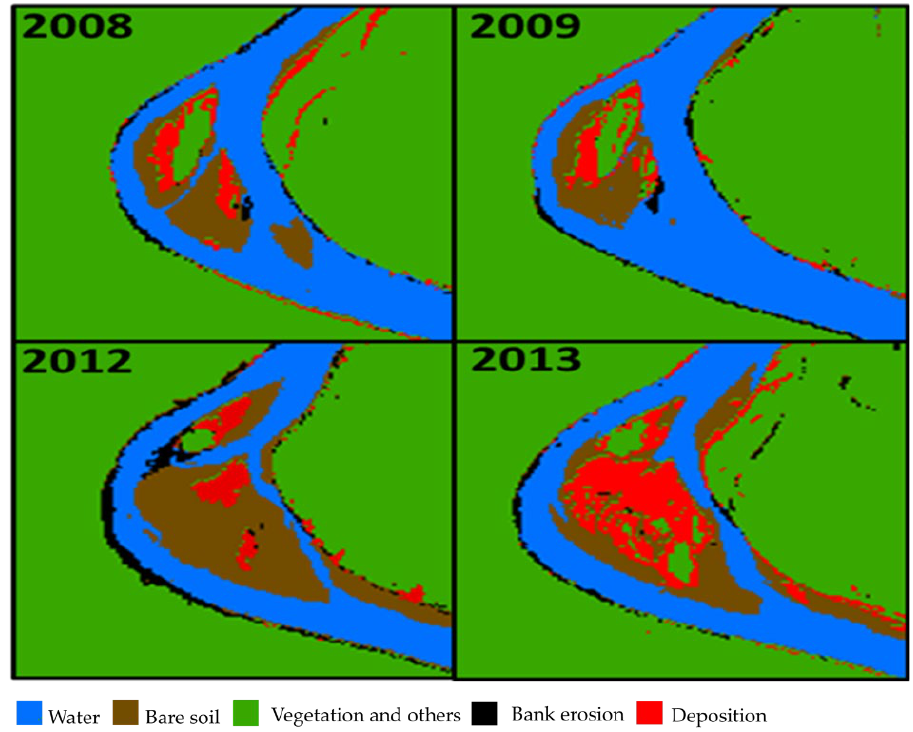
Figure 8. Main channel of the Muyuy anabranching during 2008, 2009, 2012, and 2013. More bank erosion was found in the 2012 severe flood; subsequently, a large deposition (bare soil) formed an island in 2013.